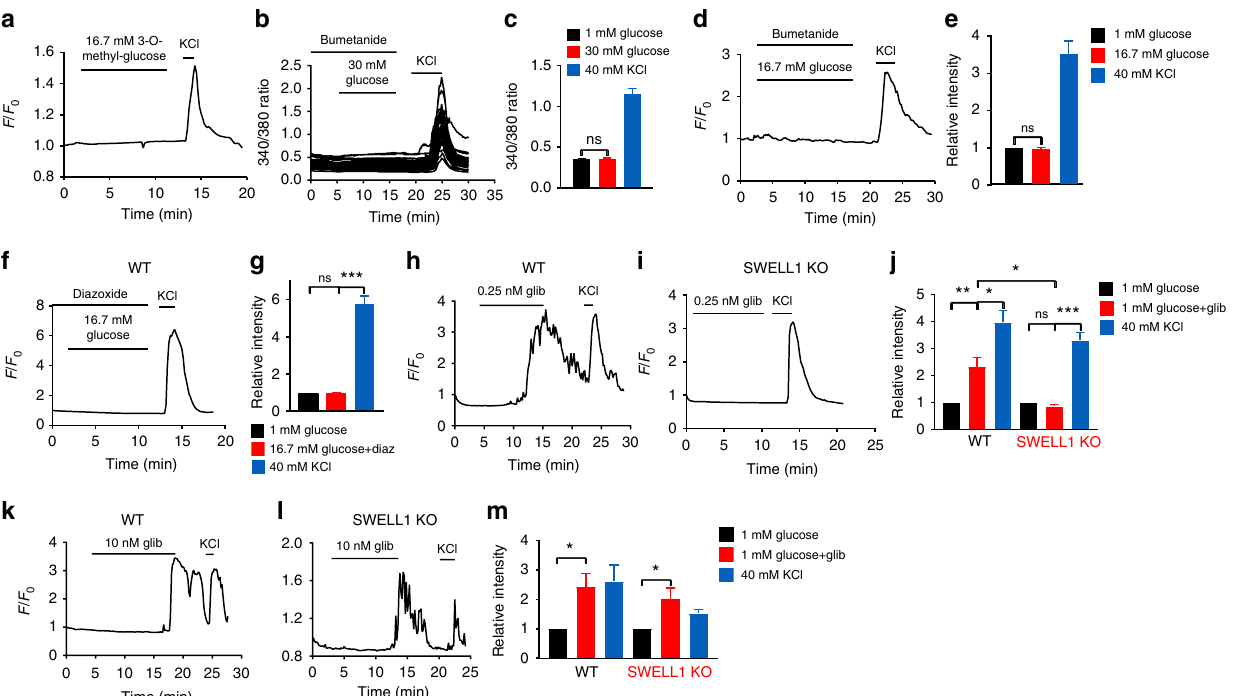
Fig. 6 SWELL1-mediated I Cl,SWELL and I KATP coordinately regulate β -cell excitability. a GCaMP6s Ca 2+ transients in WT (Ad-RIP1-GCaMP6s/ Swell1 fl / fl ) primary murine β -cells in response to 16.7 mM 3-O-Methyl-glucose-stimulation (basal 1 mM glucose) and 40 mM KCl stimulation. 3-O-Methyl-glucose fail to induce Ca 2+ transients ( n = 15 cells). b – e Glucose-induced Ca 2+ transients are inhibited in WT MIN6 cells ( b , c ) and in WT primary murine β -cells ( d , e ) by bumetanide (10 µ M; pre-incubated in bumetanide for 2 h). c Mean peak Fura-2 ratio from bumetanide-treated WT MIN6 cells ( n = 46 cells). d Mean peak values of GCaMP6s Ca 2+ transients from bumetanide-treated WT primary murine β -cells ( n = 7 cells). f , g In the presence of K ATP channel opener, diazoxide (100 µ M), glucose-induced Ca 2+ transients are abolished in WT primary murine β -cells. g Mean peak values of GCaMP6s Ca 2+ transients from WT primary murine β -cells treated with diazoxide ( n = 17 cells). h – j Low-dose glibenclamide (0.25 nM, 0 mM glucose), which is predicted to block a fraction of K ATP channels, reproducibly induced Ca 2+ transients in WT ( h ), but not Swell1 KO ( i ) primary murine β -cells. j Mean peak values of GCaMP6s Ca 2+ transients stimulated by 0.25 nM glibenclamide in WT β -cells ( n = 19 cells) and Swell1 KO β -cells ( n = 8 cells), and KCl-positive controls. k – m High- dose glibenclamide (10 nM), which has a maximal inhibitory effect on K ATP channels, activated Ca 2+ transients in both WT ( k ) and Swell1 KO β -cells ( l ). m Mean peak values of GCaMP6s Ca 2+ transients stimulated by 10 nM glibenclamide in WT β -cells ( n = 4 cells) and Swell1 KO β -cells ( n = 4 cells). Data are shown as mean ± s.e.m. One-way ANOVA for in-group comparison, unpaired t -test for between-group comparison. * p < 0.05, ** p < 0.01, *** p < 0.001.